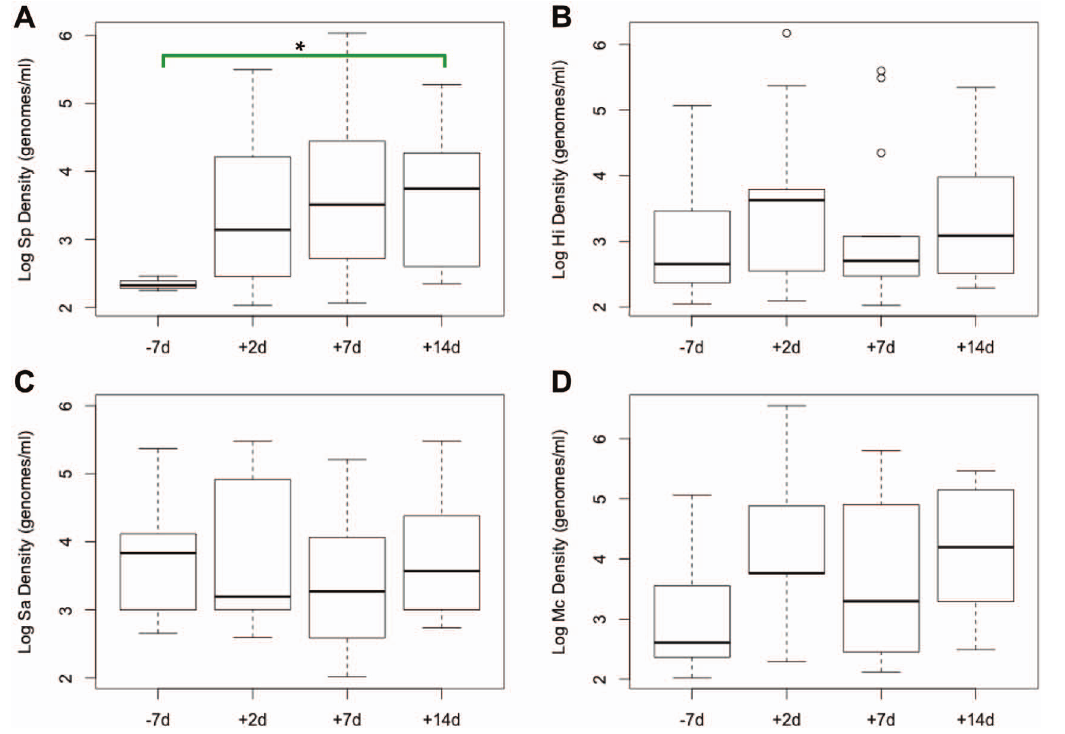
Figure 3. Density of Sp (A), Hi (B), Sa (C), and Mc (D) in nasal wash samples at four time points. Boxplots of log bacterial density (in genomes/ml) of all samples with . 100 genomes/ml at each time point. Boxplots indicate median, interquartile range, and range with circles indicating outlier values. Asterisk indicates p =0.003.